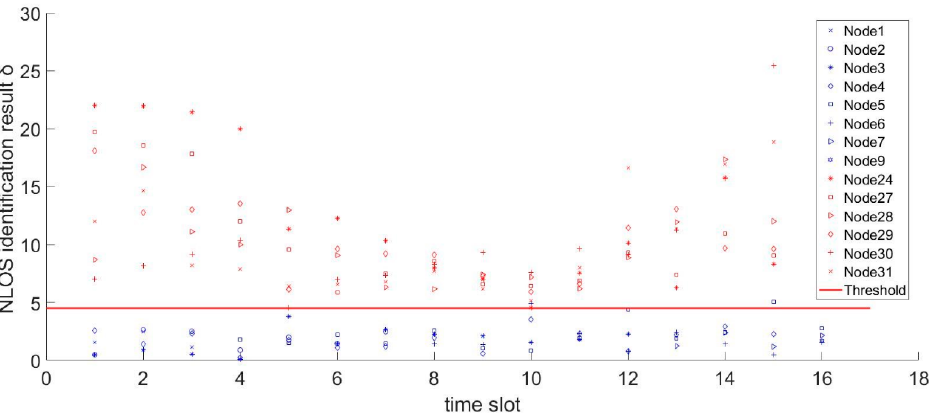
Figure 15. The evaluation results of the proposed NLOS identification method (the average NLOS rate ≈ 0.6).